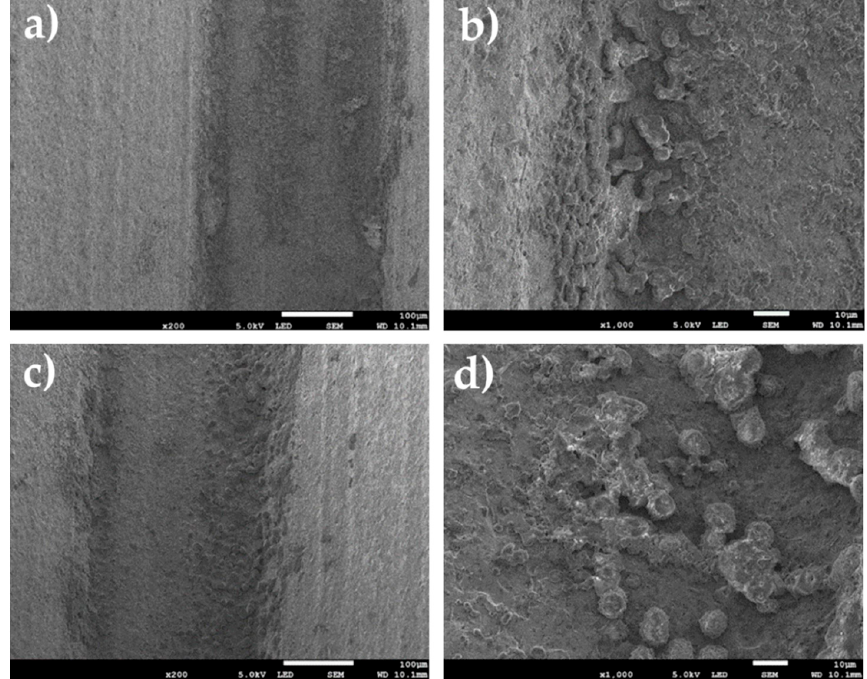
Figure 6. Surface of reference specimen after corrosion test at different magnifications: ( a ) surface of helix top ×200, ( b ) surface of helix top ×1000, ( c ) bottom of the helix ×200, ( d ) bottom of the helix ×1000.